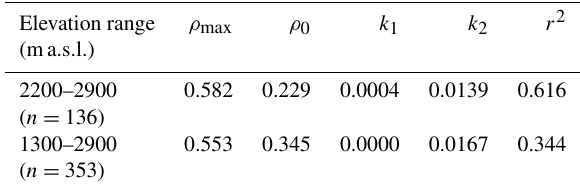
Table 4. Model parameters by elevation bands for nonzero